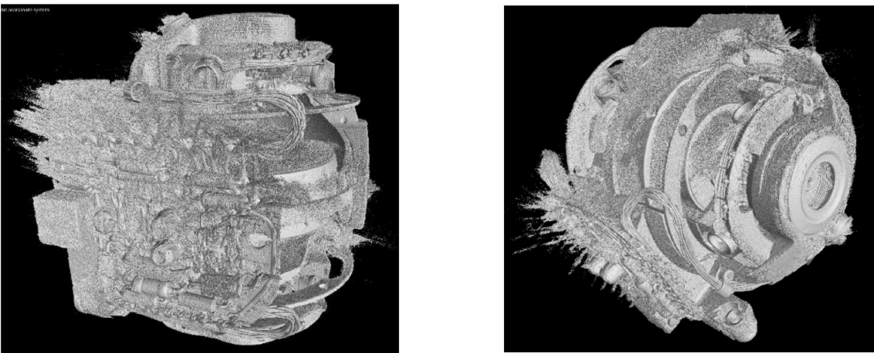
Figure 13. Two views of the iso-surface of G200 from the 3D volume data set reconstructed by the FBP.